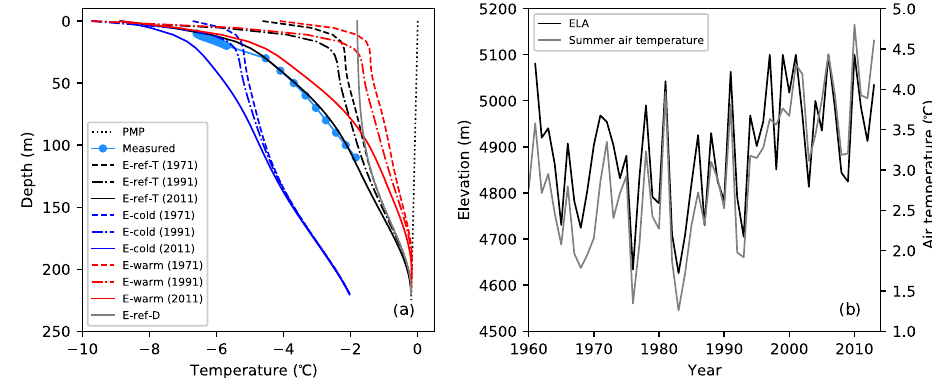
Figure 11. (a) Modelled temperature profiles in the deep borehole for experiments E-ref-T (black line), E-cold (blue line), E-warm (red line), and E-ref-D (gray line). Dots indicate the measured ice temperature profile. Pressure melting point is indicated by the dotted line. (b) The variations of ELA and summer air temperature at 4200ma . s . l . during 1961–2011.